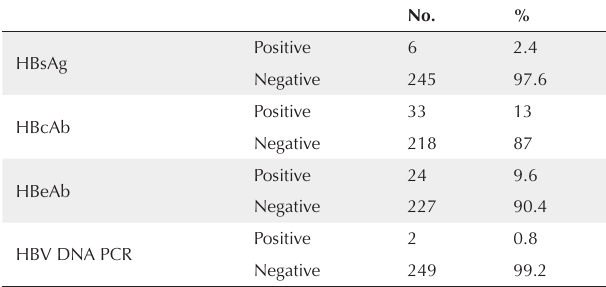
Table 2. Prevalence of Hepatitis Infection